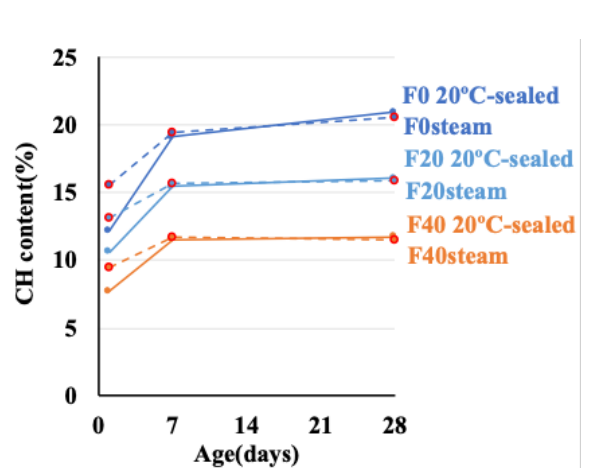
Figure 3. k-value of fly ash with age.